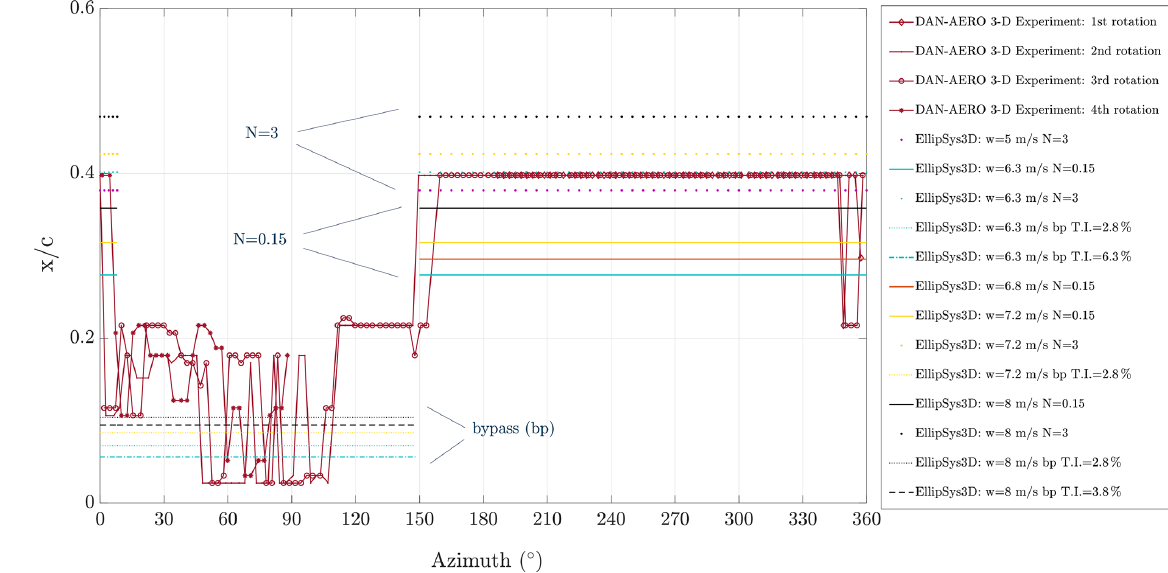
Figure 14. Experimentally detected transition locations as a function of the azimuthal angle for the case at w = 6 . 3ms − 1 , T . I . = 6 . 3%, and p = 4 . 75 ◦ showing four revolutions. The EllipSys3D simulation results are labeled by the colors for various free-stream velocities, i.e., black: w = 8ms − 1 , yellow: w = 7 . 2ms − 1 , orange: w = 6 . 8ms − 1 , turquoise: w = 6 . 3ms − 1 , and purple: w = 5ms − 1 ( N = 0 . 15, N = 3, and N = 7 correspond to T.I. values of 2.8%, 0.85%, and 0.16%,